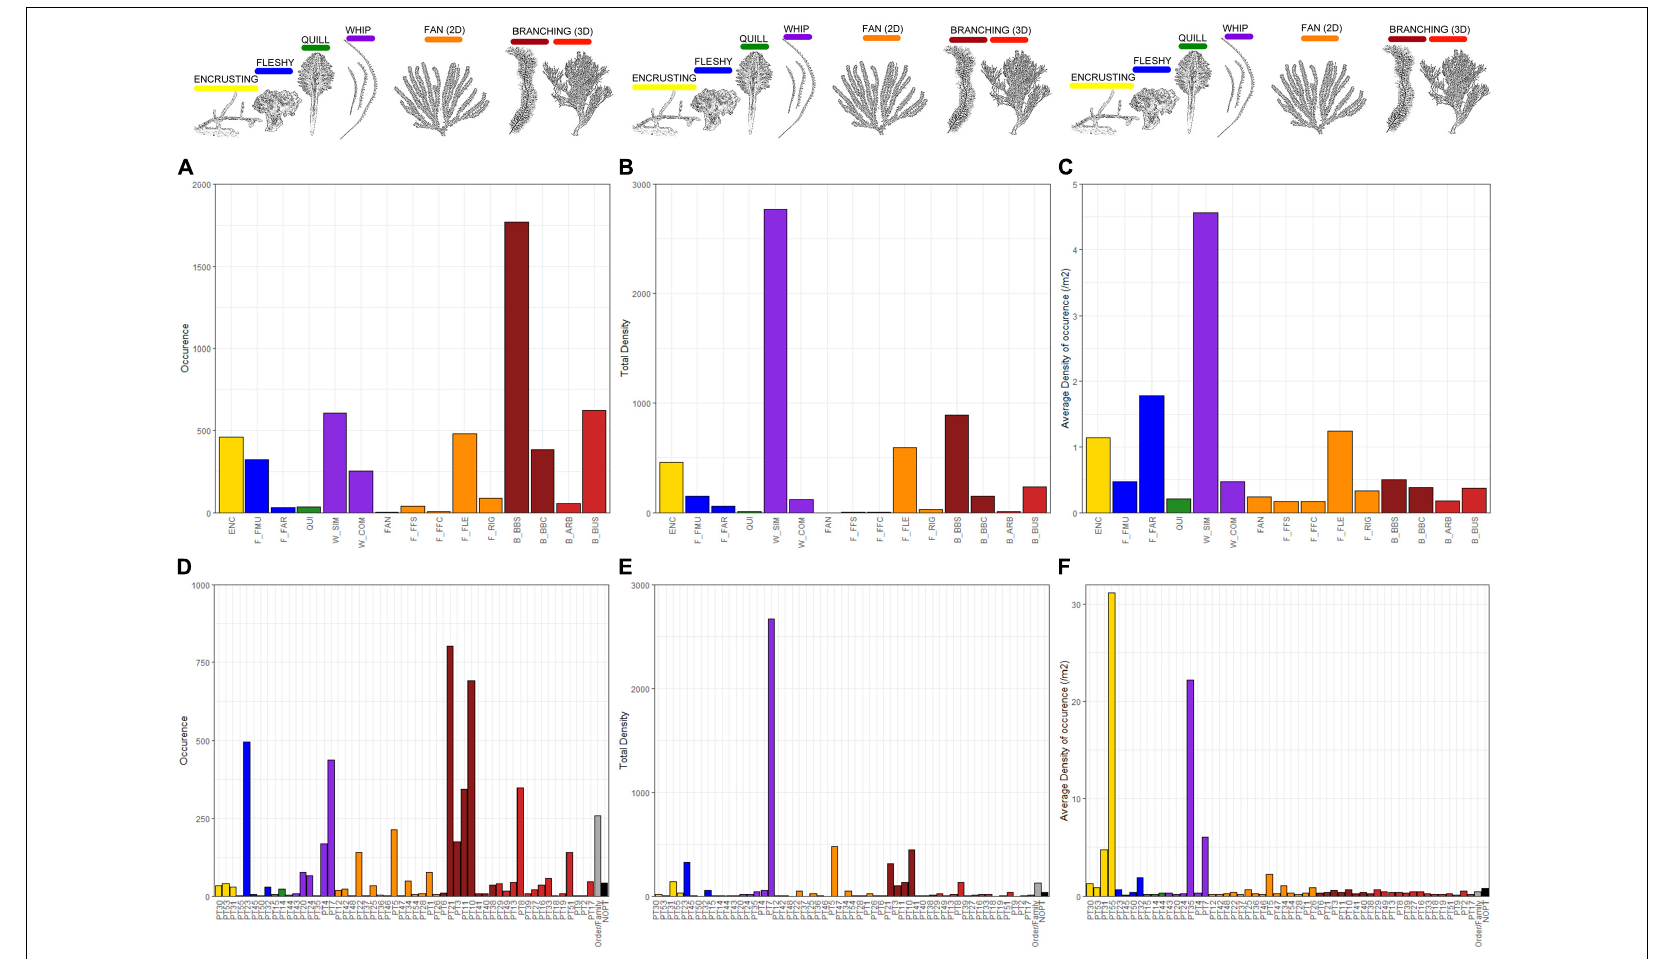
FIGURE 5 | Metrics of occurrence, total and average density (per m 2 of occurrence) calculated across the analyzed data set ( n = 2 075 images) for the CATAMI (A–C) and Phototaxa 2018 (D–F) classification schemes. ENC, encrusting; F_FMU, Fleshy: mushroom; F_FAR, Fleshy: arborescent; QUI, Quill; W_SIM, whip: simple; W_COM, whip: complex; FAN, Fan(2D); F_FFC, Fan(2D): Fern-frond: simple;